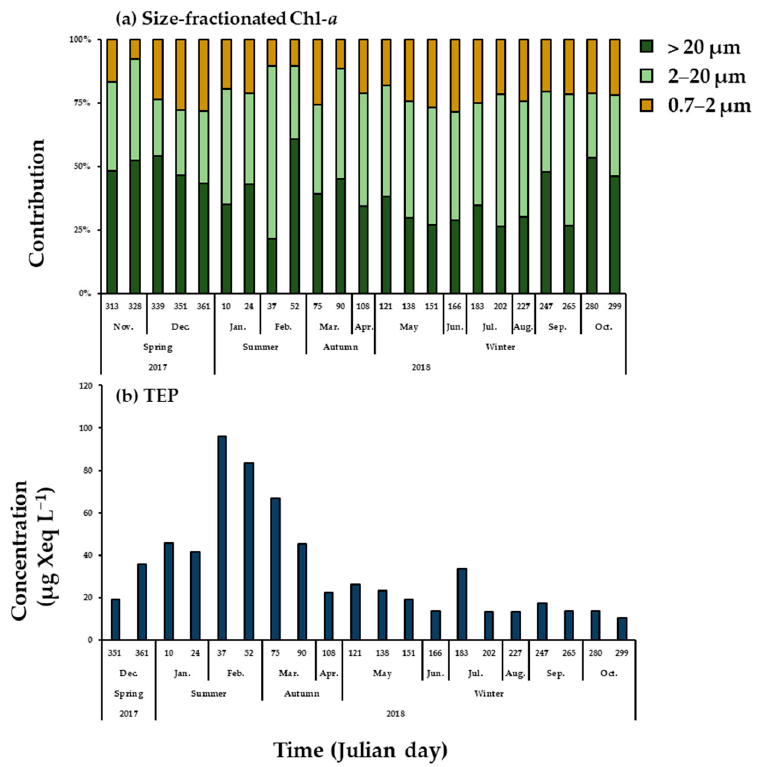
Figure 5. Contributions of different size-fractionated Chl- a concentrations to the total Chl- a concentration ( a ) and trans parent exopolymer particles (TEPs) concentrations ( b ) at the JBS during our sampling period.